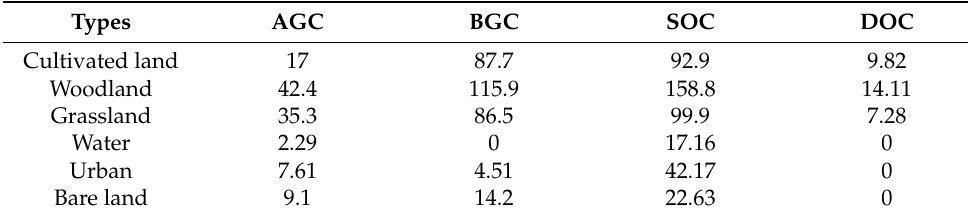
Table 2. Carbon density of each land use type in the InVEST model (unit: Mg/hm 2